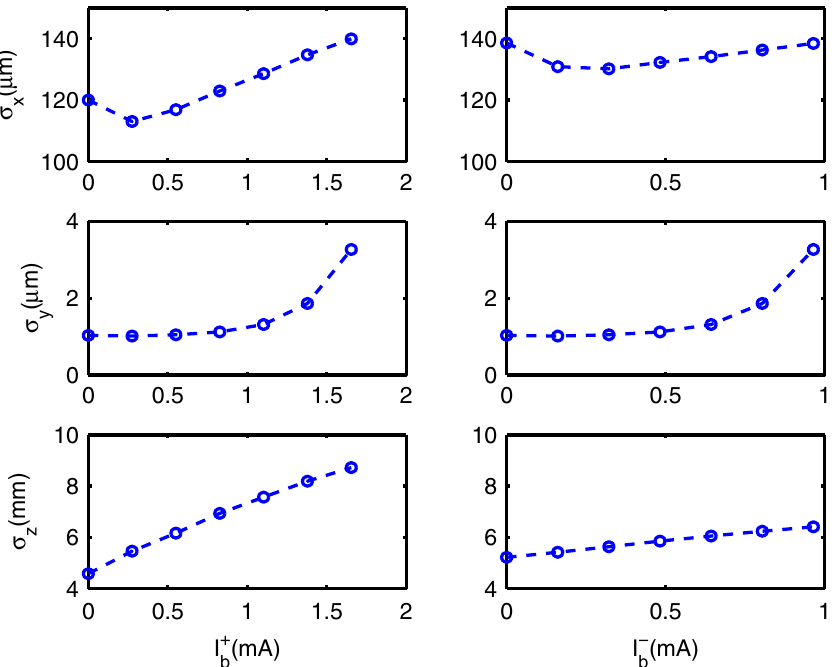
FIG. 10. (Color) Beam sizes in all three dimensions of colliding beams as a function of its current increased with a fixed ratio to the other.